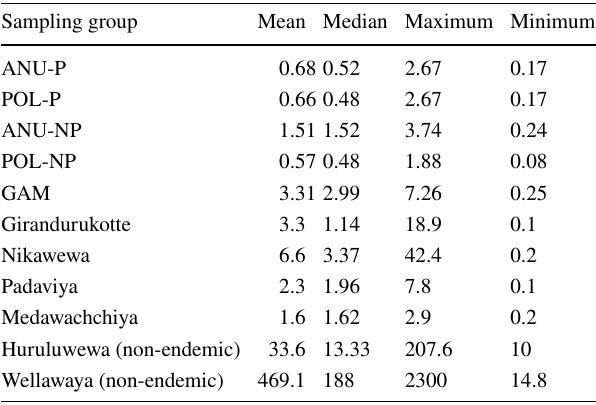
Table 13 Sodium to calcium ratio (Na + /Ca 2+ ) for primary and sec- ondary